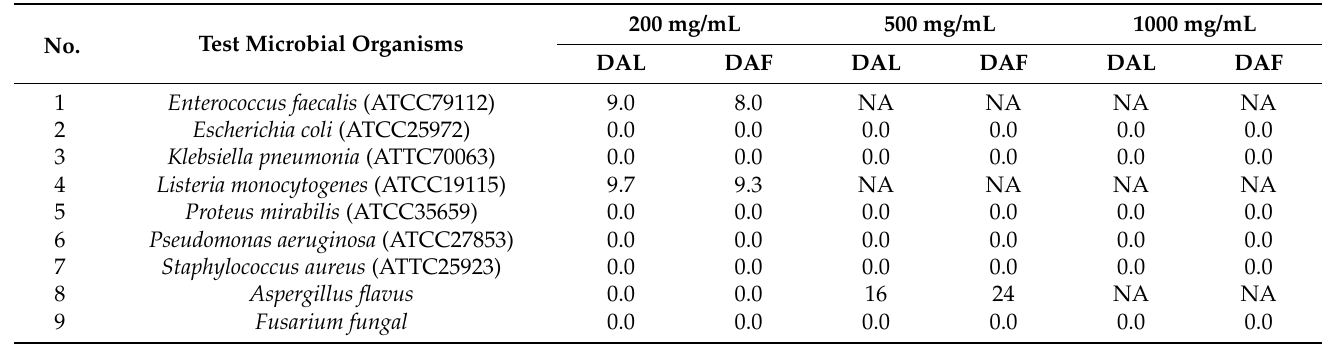
Table 5. The mean of inhibition zone of different crude extracts of assay of the antimicrobial test result.